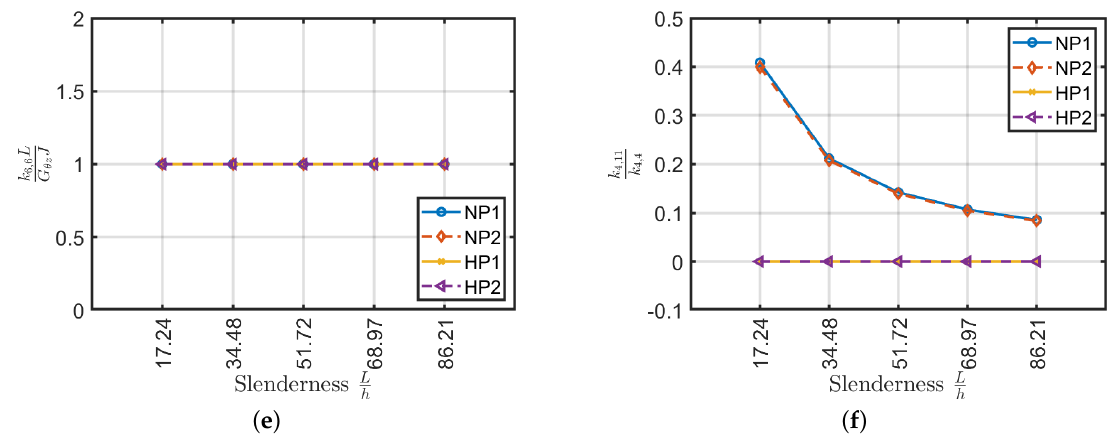
Figure 18. Stiffness coefficients as a function of slenderness for ( 15 2 /30 2 ) s and ( ± 15/ ± 30 ) s ( a – e ) and stiffness ratio k 4,11 / k 4,4 ( f